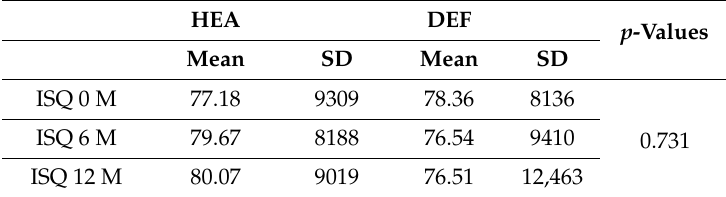
Table 8. Evolution of Implant Stability /